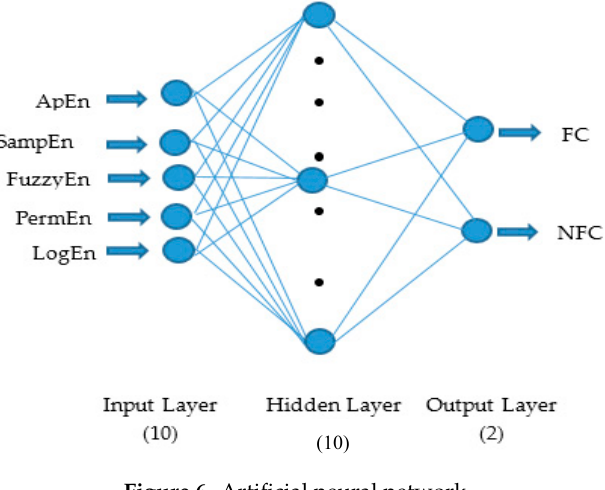
Figure 6. Artificial neural network.